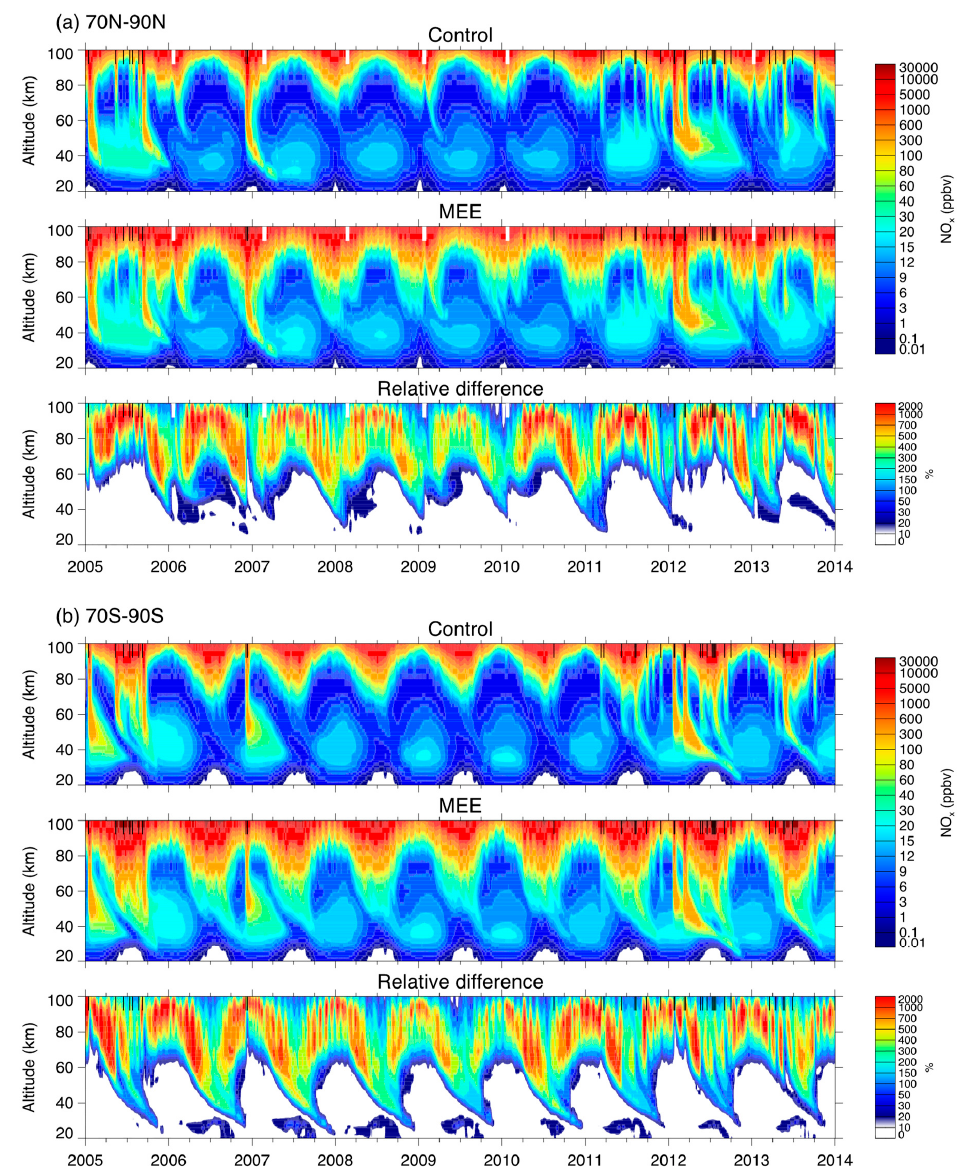
Figure 2. The vertical profiles of NO x volume mixing ratio (VMR) averaged over the latitude range of 70 ◦ –90 ◦ N/S in the middle atmosphere from the control and MEE runs and their relative differences ((MEE-Control)/Control) during the period from 2005 to 2013 are presented. The 10-day moving average is applied for these figures. The black short lines at the top of each panel indicate the occurrences of solar proton events (SPEs) and the white short lines indicate the stratospheric sudden warming (SSW). Figure 3 shows the seasonal variations of the MEE effects by the relative changes in the daily mean profiles for NO x , HO x , and ozone VMRs in the NH (top panels) and SH (bottom panels). Note that the winter months are centered in the figure for both hemi- spheres. Positive differences in the left and middle panels indicate the enhanced NO x and HO x due to the MEE precipitation included in the MEE runs and negative differences at